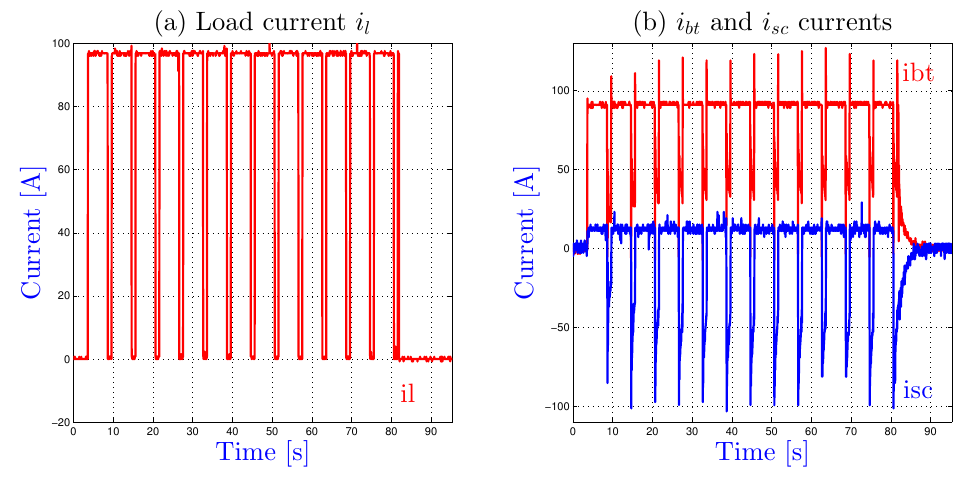
Figure 11. Experimental results during nominal condition.